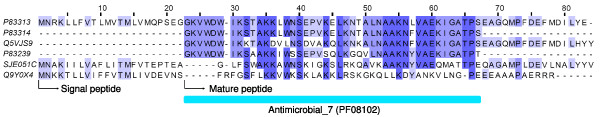
Sequence alignment of Opistoporin like peptides. SJEs are clusters from this work. The others are P83313 (Opistoporin-1, Opistophthalmus carinatus), Q5VJS9 (Opistoporin4, Opistophthalmus carinatus), Q9Y0X4 (Bradykinin-potentiating peptide BmK3, Mesobuthus martensii), P83314 (Opistoporin-2, Opistophthalmus carinatus), and P83239 (Pandinin-1, Pandinus imperator).